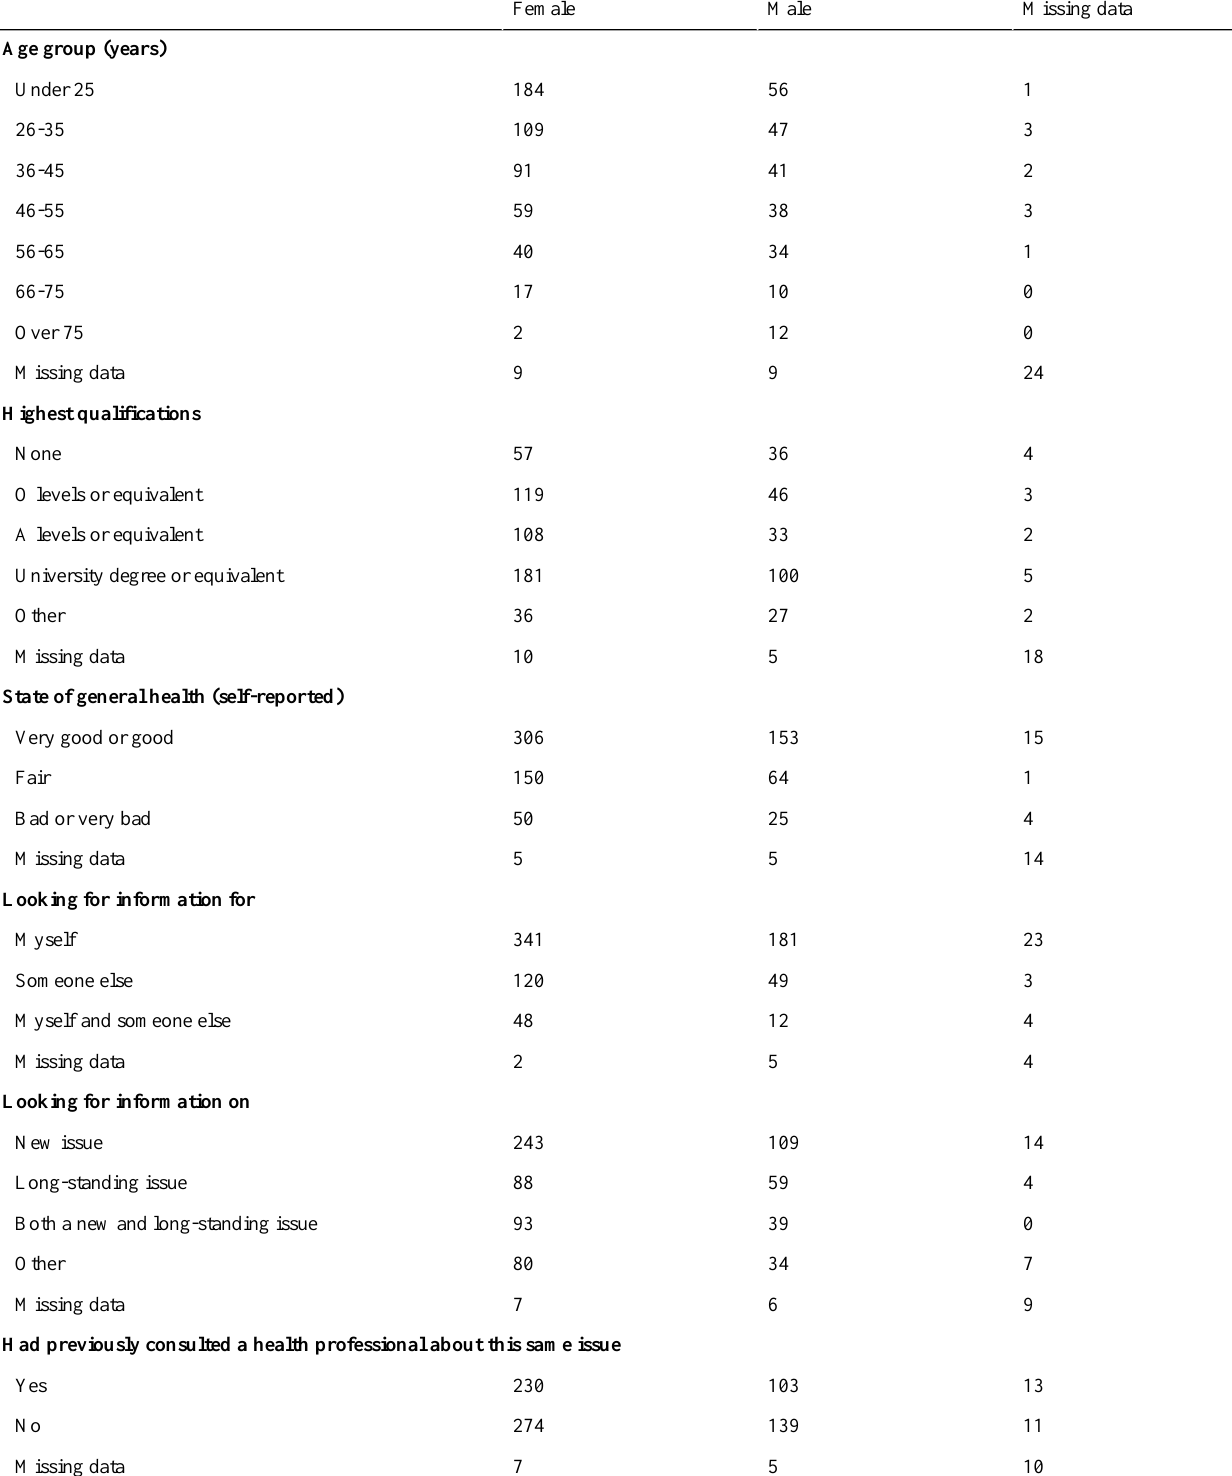
Table 2. Survey responses by gender (missing data reported because partially completed surveys were included in the analysis). Total respondents N =